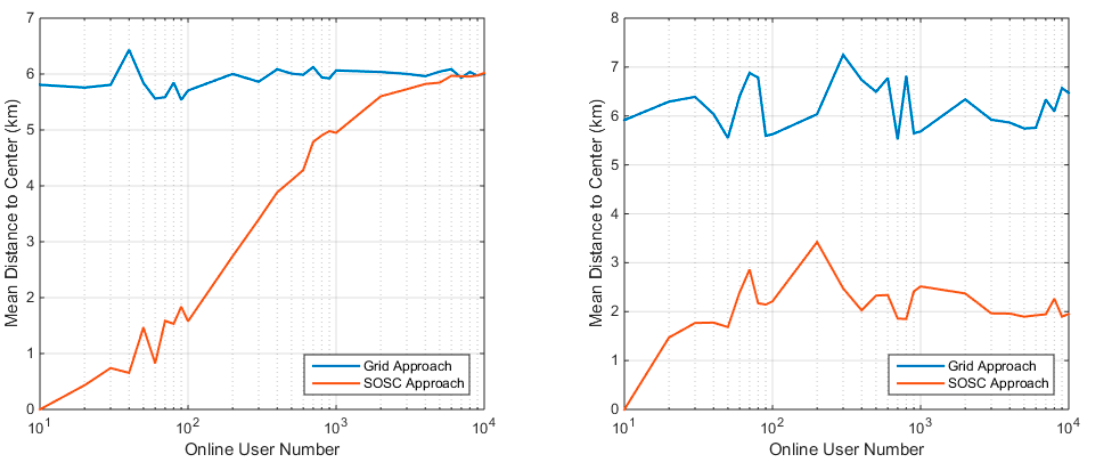
Figure 11. The mean distance to cluster center of different clustering approach under uniform distribution ( left ) and clustered distribution ( right ).